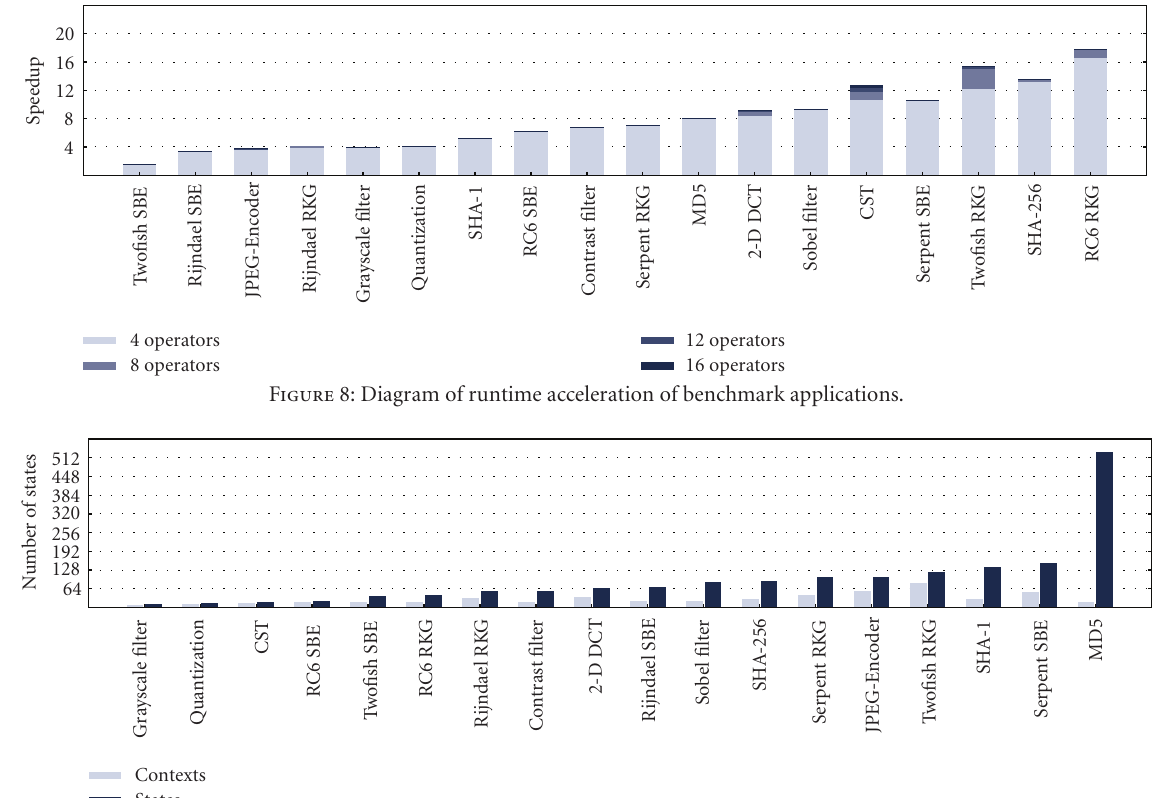
Figure 9: Diagram of complexity of the schedules of benchmark